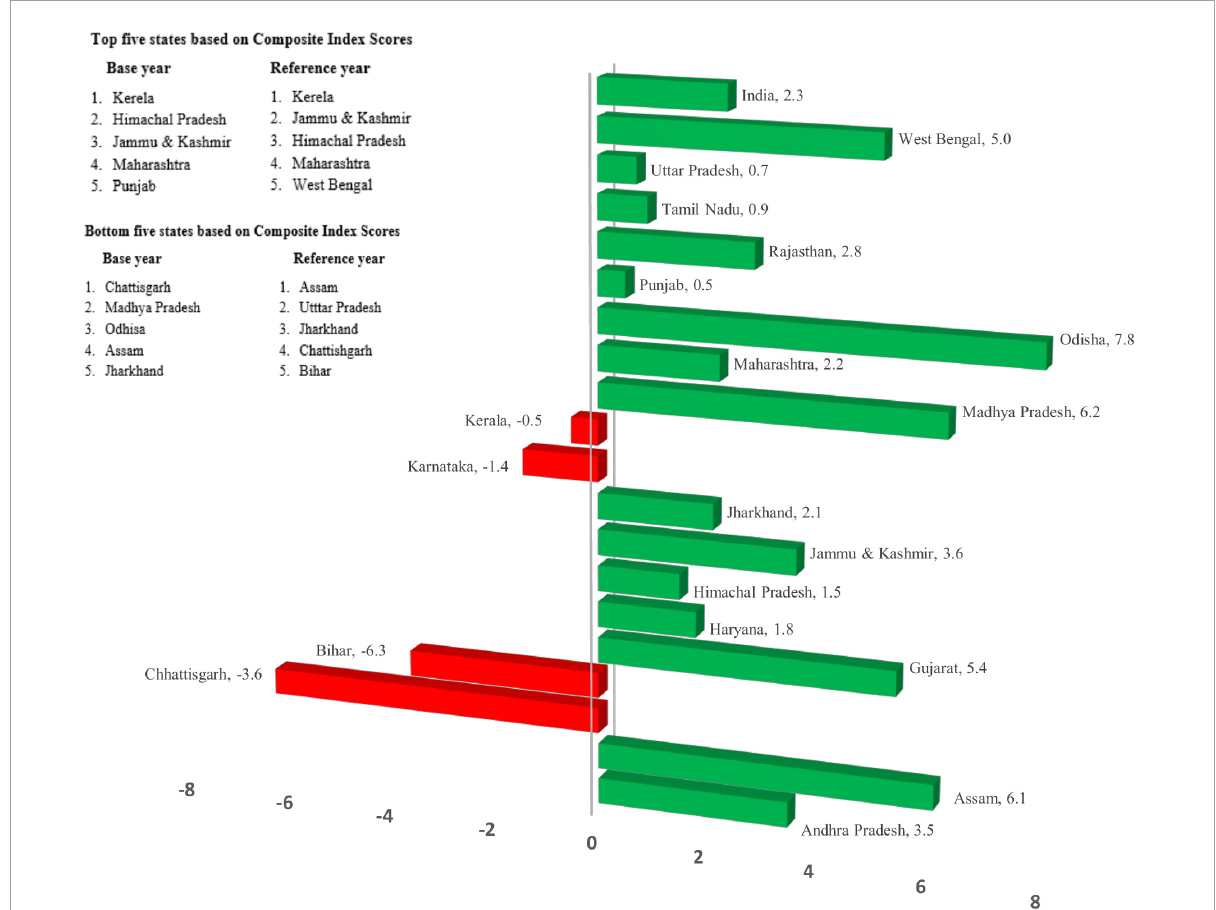
FIGURE3 Positive and negative incremental changes in composite age-specific mortality index scores along with top and bottom performing states for rural Indian